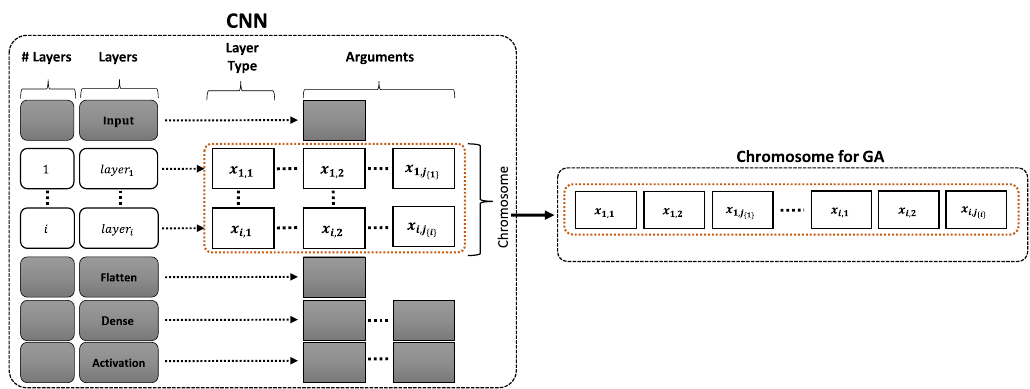
Figure 5. Chromosome generation process using the restrictions that were previously configured in the framework database. indicated the j -th gene used to code a parameter of the i -th layer. Gray shaded boxes indicate the fixed layers not x ij { i } included in the optimization process.